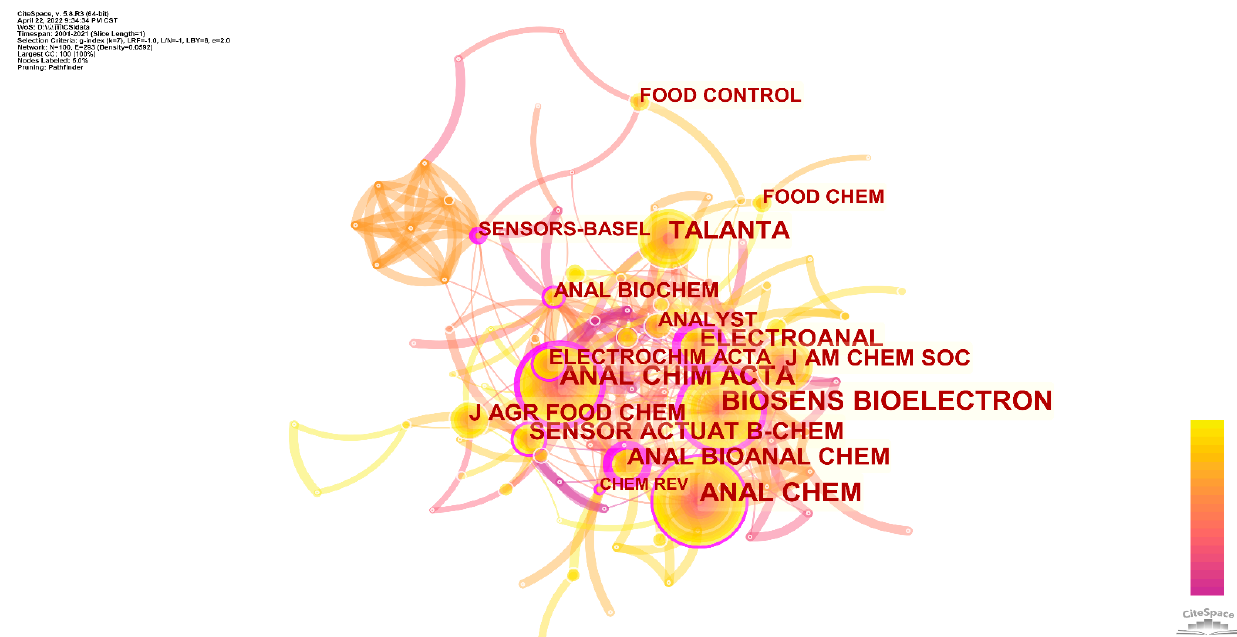
Figure 3. Co-occurrence network of cited journals for electrochemical techniques for detection and analysis of GM crops. Table 2. List of journals that have appeared in the co-occurrence network in the last three years.